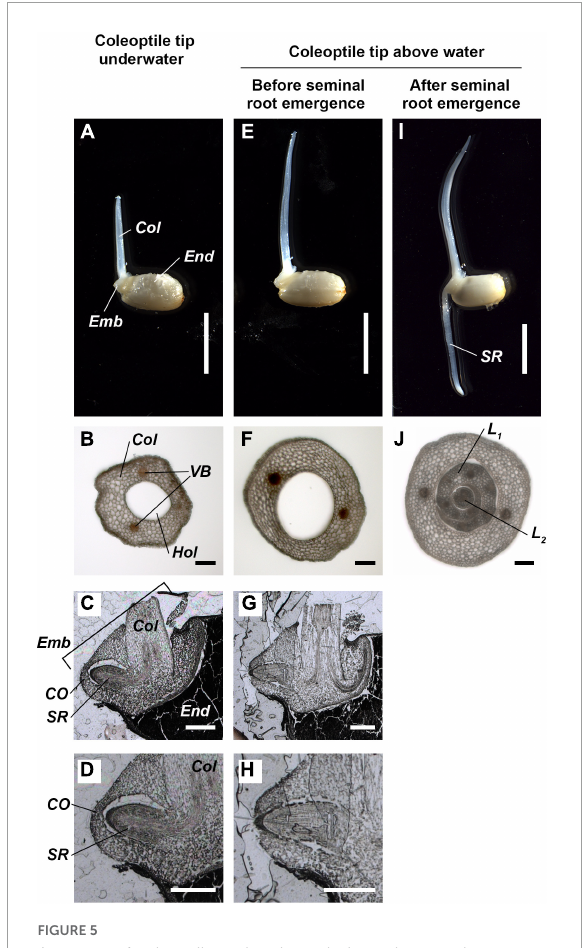
FIGURE5 Anatomy of coleoptile and embryo during submerged germination below a normoxic atmosphere. (A–D) The coleoptile tip was underwater. (E–H) The coleoptile tip was above water, but seminal roots have not yet emerged. (I,J) The coleoptile tip was above water and after seminal root emergence. Cross-sections of the coleoptile at the 5 mm from the embryo (B,F,J) . Cross-sections of the embryo (C,D,G,H) . Col , coleoptile; CO , coleorhiza; Emb , embryo; End , endosperm; Hol , hollow; L 1 , 1st leaf; L 2 , 2nd leaf; SR , seminal root; VB , vascular bundles. Scale bars: 5 mm in (A,E,I) ; 100 µ m in (B,F,J) ; 500 µ m in (C,D,G,H) .